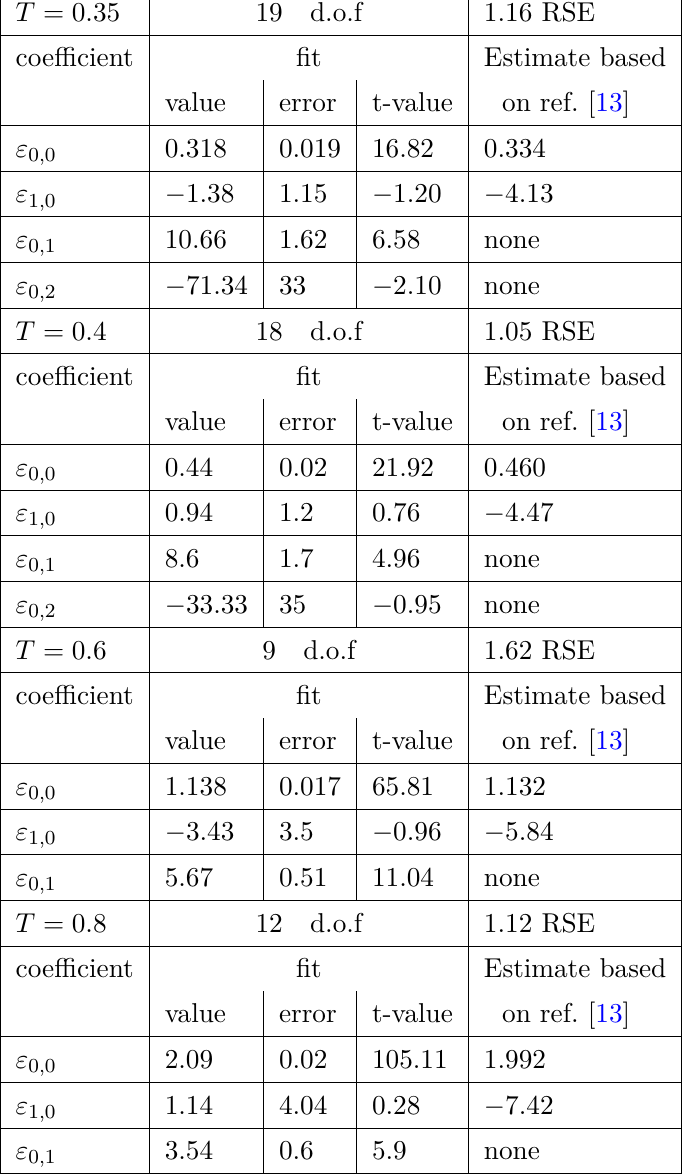
Table 3 . In this table we collect simultaneous large N and continuum fits for T > 0 . 3 temperatures at µ = 0 . 5 . All other coefficients in (5.1) are set to zero. Residual standard errors (RSE) and degrees of freedom (d.o.f) are shown. As noted in the main text, the energies suffer from a systematic error due to the limited fitting